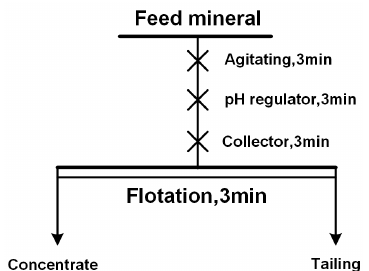
Figure 2. Flowsheet of the flotation tests.